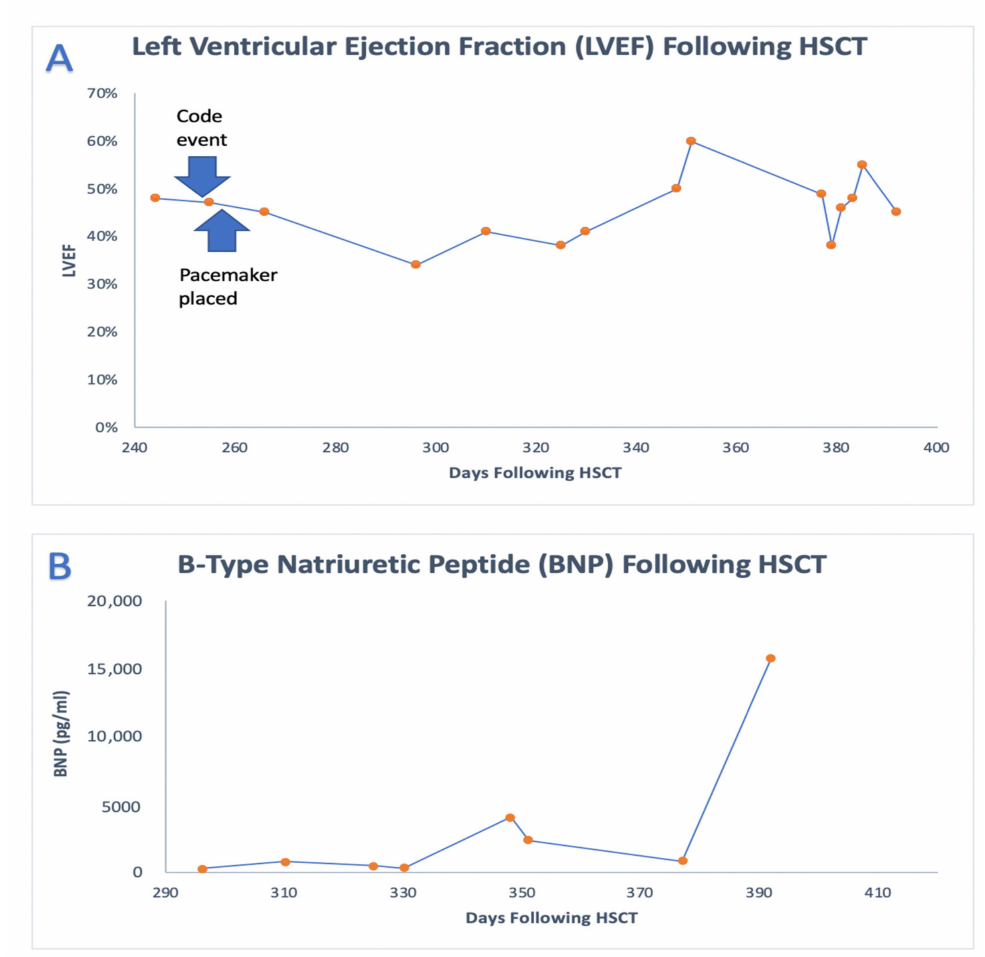
Figure 5. The trends of the left ventricular ejection fraction (LVEF) and B-type natriuretic peptide (BNP) following HSCT are detailed. ( A ) The post-HSCT trend in LV ejection fraction (LVEF) following the patient’s code event and eventual pacemaker placement. ( B ) The patient’s post-HSCT B-type natriuretic peptide (BNP) level, which increased during times of acute cardiac